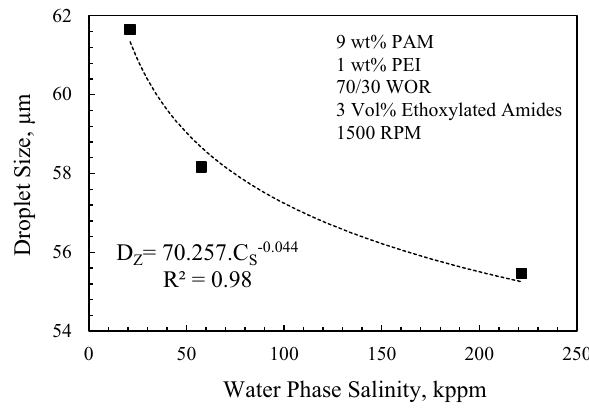
Fig. 6 Droplet size of the emulsified gels at different emulsifier